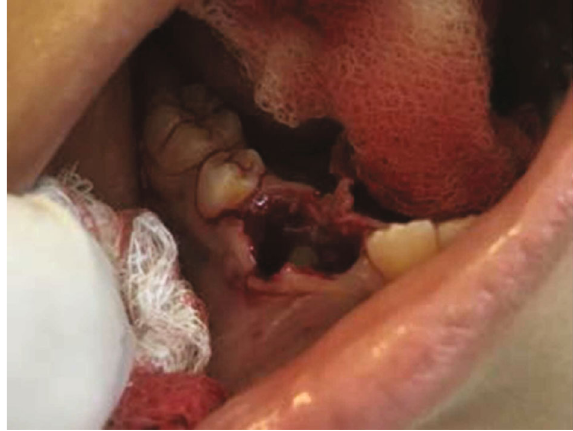
Figure 6: Decompression of the cyst and inspection of the right fi rst premolar (tooth